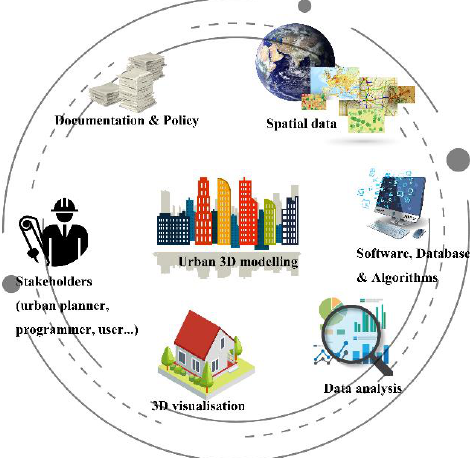
Figure 1. The components of urban 3D